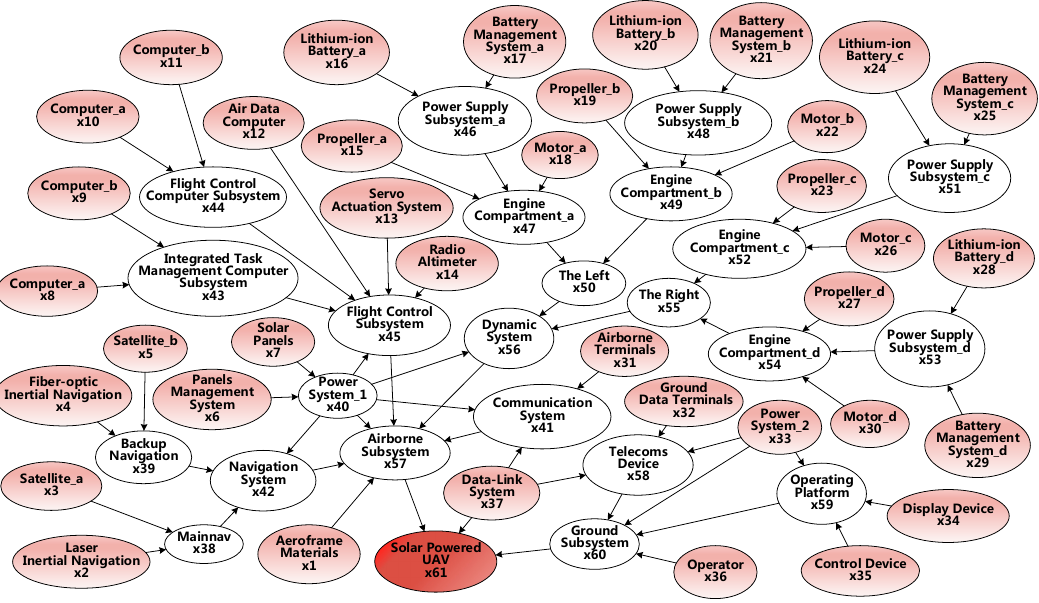
Figure 12. DAG of a solar-powered unmanned system.